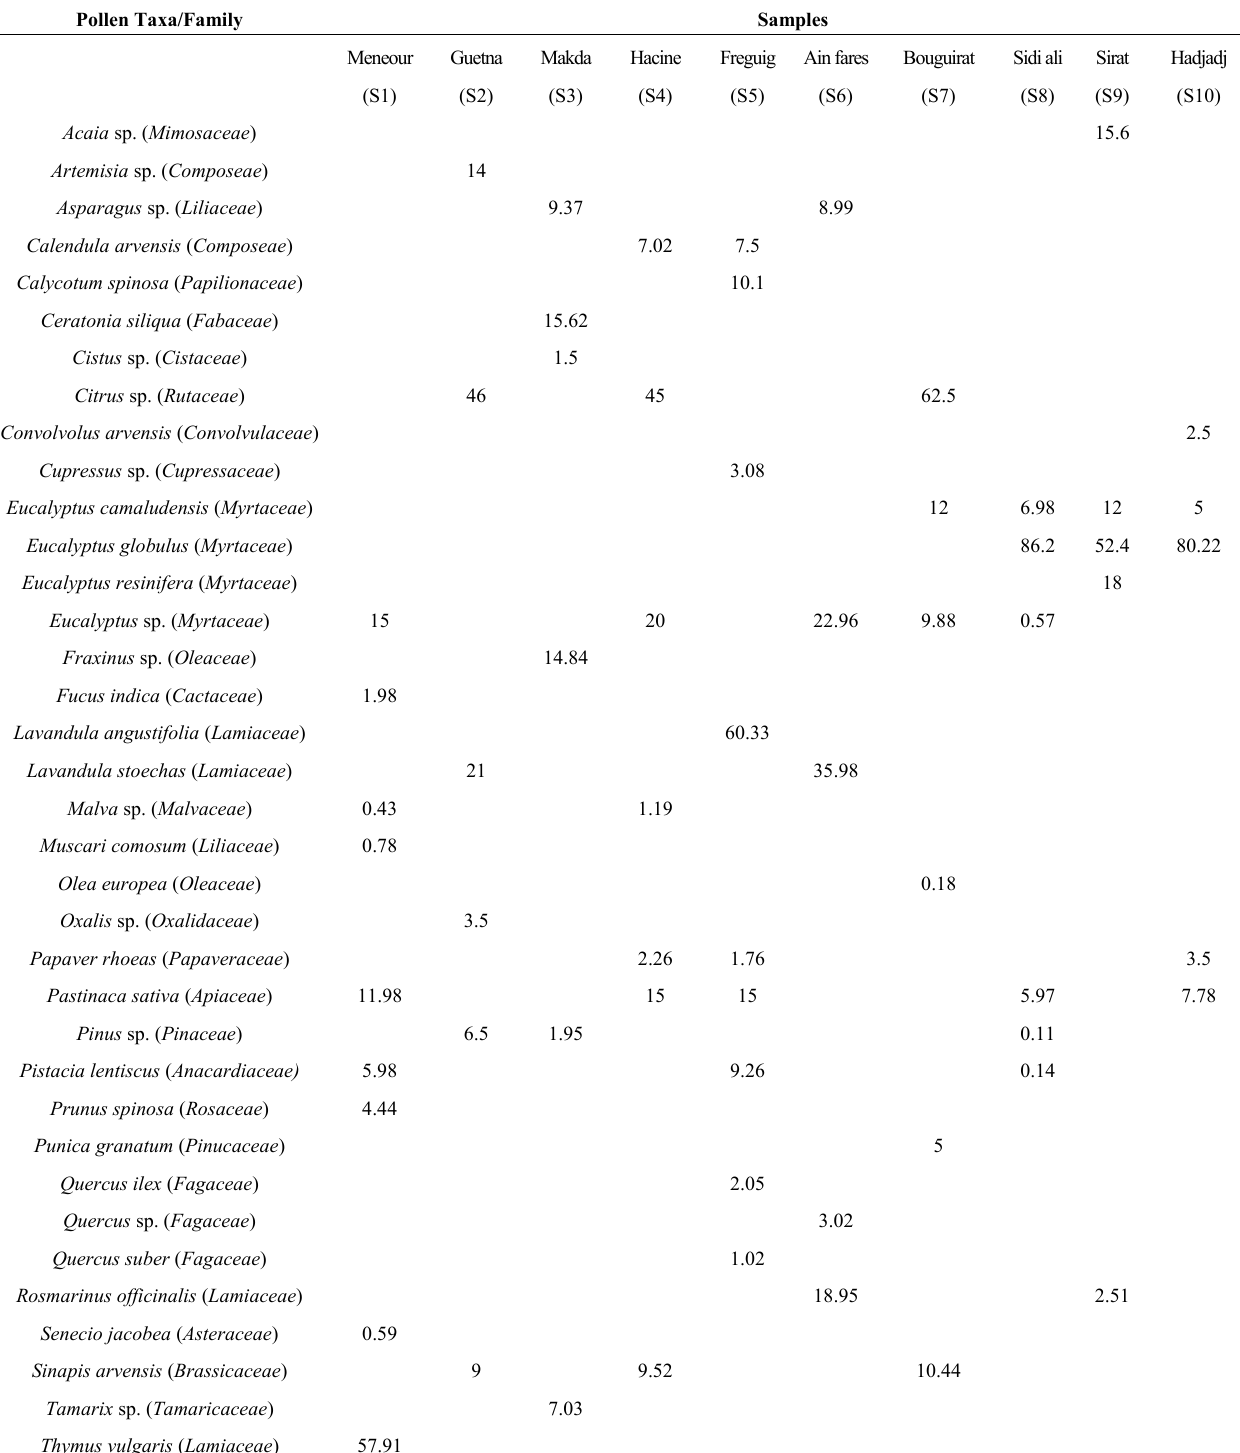
Table 1. Pollen content in the honey samples